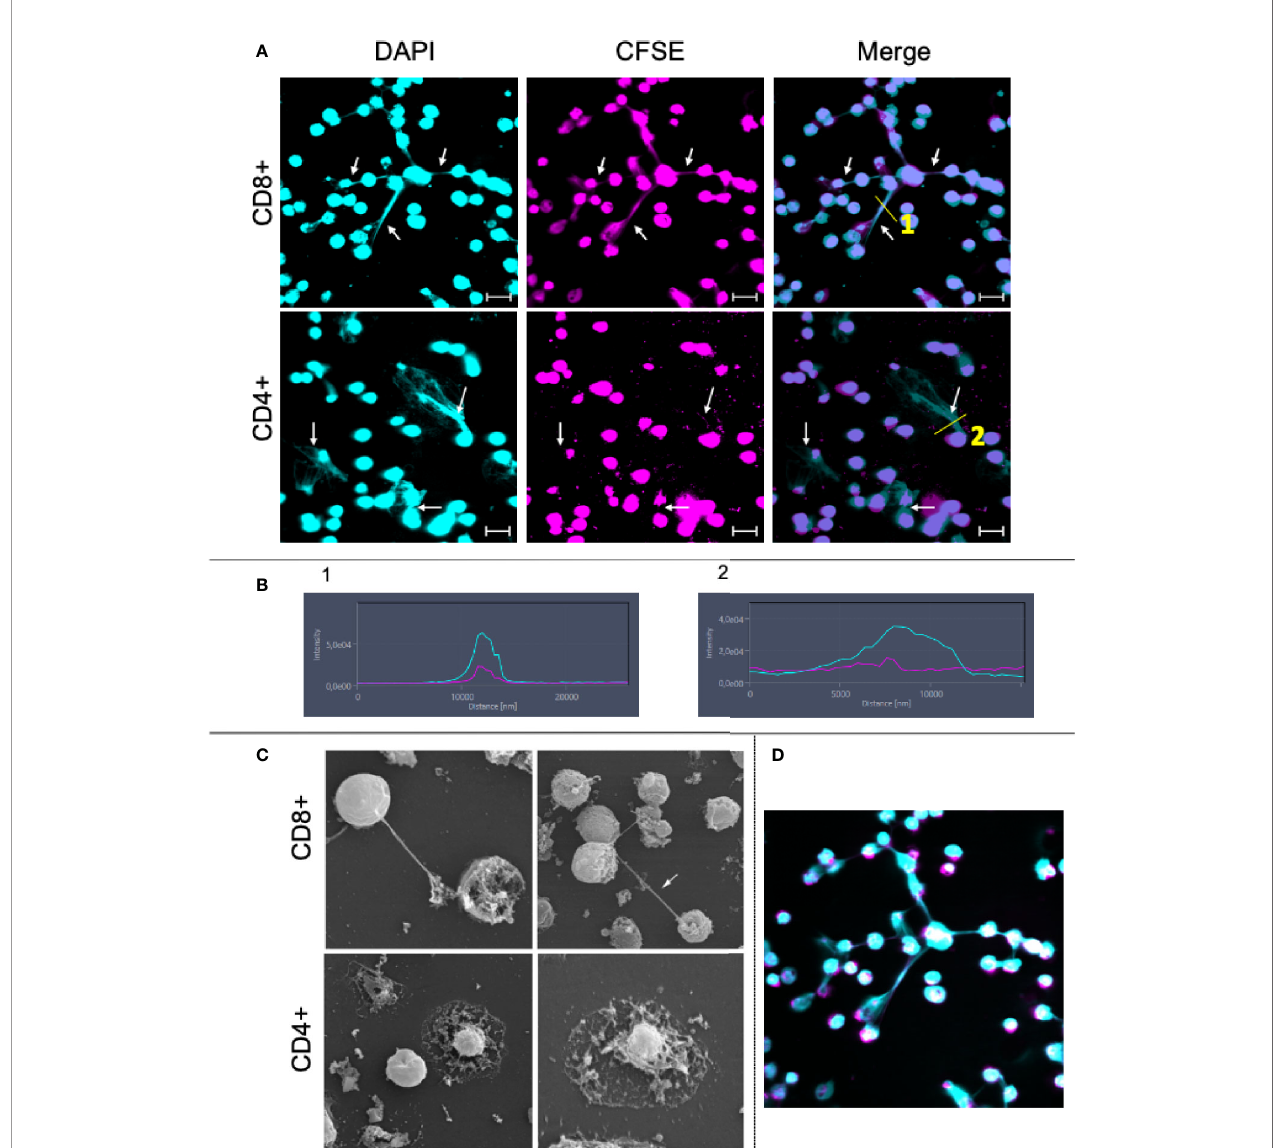
FIGURE 4 | Puri fi ed CD8+ and CD4+ T lymphocytes release extracellular traps (ETs) upon stimulation. Puri fi cation of CD8+ and CD4+ T lymphocytes was done by sorting as described in Material and Methods. (A) CD8+ and CD4+ lymphocytes were stained with CFSE, plated on poly-L-lysine coverslips and stimulated with anti- CD3/anti-CD28 for 24 h. After incubation the cells were stained with DAPI as described in the Materials and Methods. Representative images from confocal microscopy analyses for show the DAPI+ (light blue) cells, CFSE+ (pink) cells and for both. Arrows highlight the extracellular traps. Bars = 20 m m. (B) shows histograms derived from the details marked with (1) and (2) in panels (A) , demonstrating the co-localization of DAPI and CFSE in CD8-derived and CD4-derived ETs, respectively. (C) CD8+ and CD4+ cells were stimulated and processed for SEM analysis, as described. Lymphocytes cells were plated on poly-L-lysine coverslips, stimulated with anti-CD3/anti-CD28 and maintained in culture for 48 h. The left CD8+ and CD4+ images have a magni fi cation of 3,000× while the right ones, 5,000×. Arrow: structure connecting cells. (D) Confocal image obtained by staining with CFSE (pink) and DAPI (blue, as above) showing CD8+ T cell-derived DNA fi lament connecting